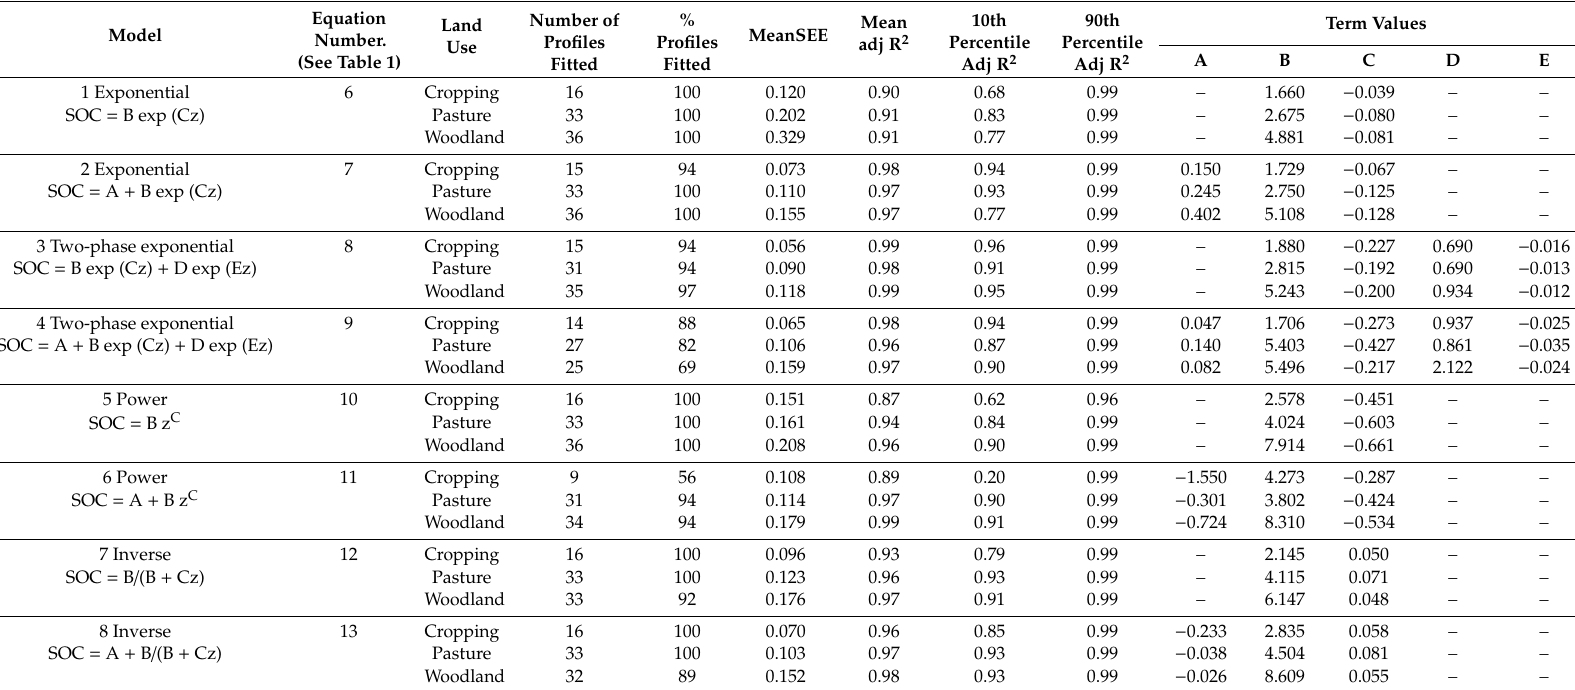
Table 3. Mathematical models of the depth distribution of SOC for di ff erent land uses. Standard Error of Estimate (SEE) and adjusted R 2 of fits of functions to 85 data sets of SOC distributions to ≈ 100 cm from NSW Australia. Moreover, mean values for parameters of equations where the optimisation process converged and the mathematical functions could be fitted to the data, are included. The symbol “–“ indicates that the parameter does not occur in the